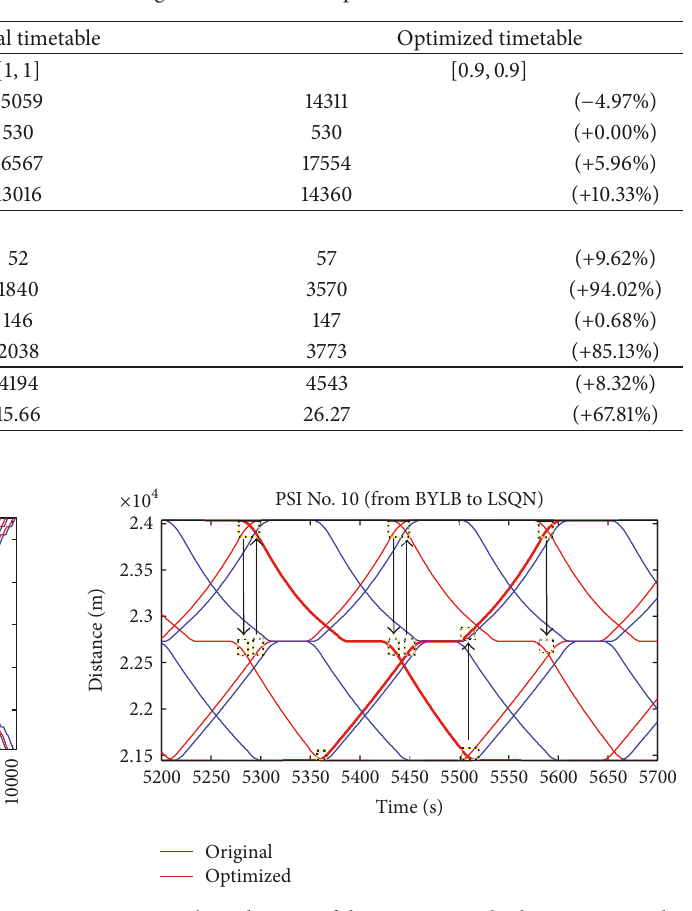
Table 5: Comparison of energy consumption between the original timetable and optimized timetable.